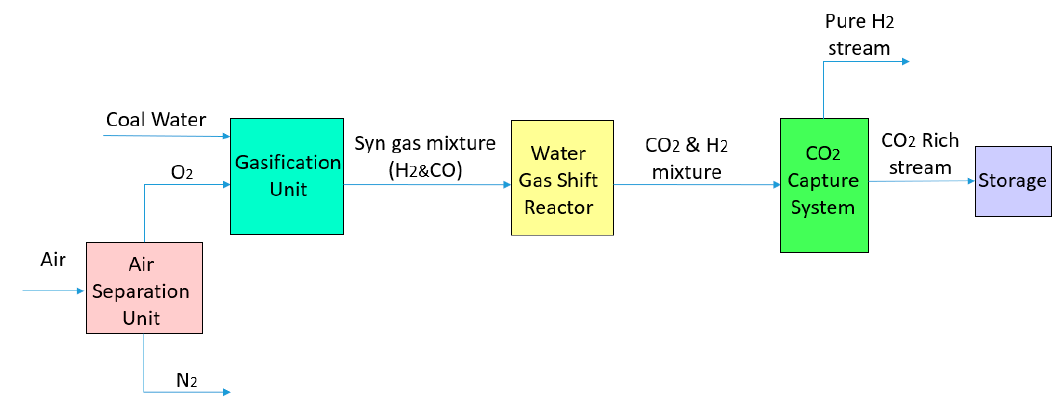
Figure 4. Block flow diagram of pre-combustion carbon capture system.